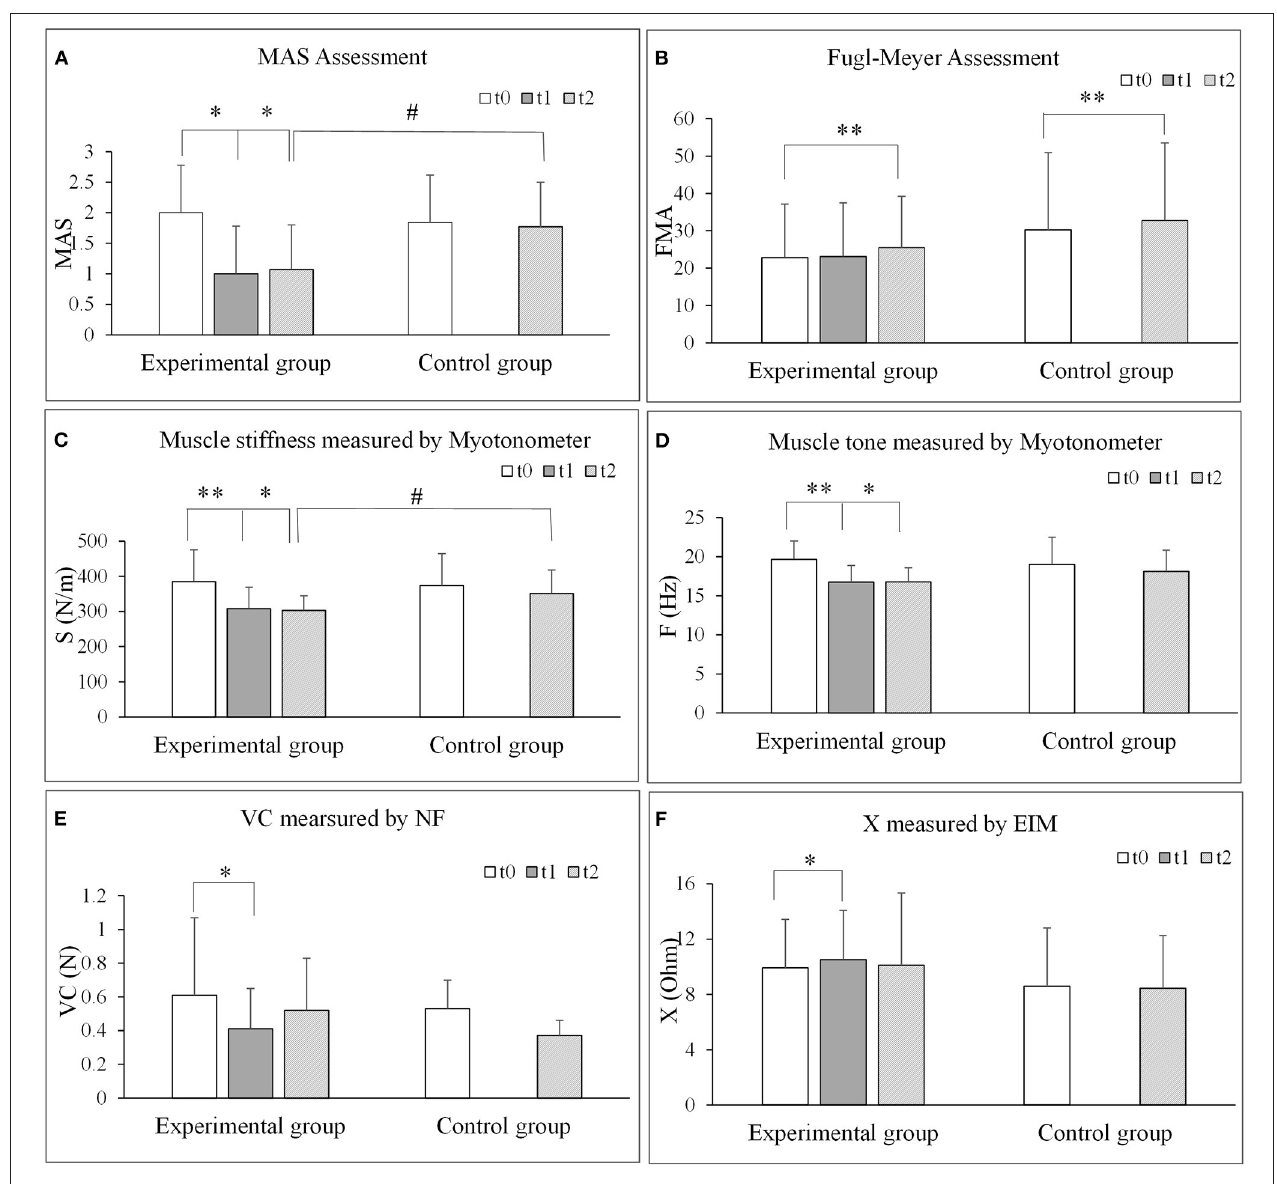
FIGURE 6 | Comparisons of each outcome measures before and after extracorporeal shock wave therapy. (A) MAS assessment. (B) Fugl-Meyer assessment. (C) Muscle stiffness measured by Myotonometer. (D) Muscle tone measured by Myotonometer. (E) VC measured by NF. (F) X measured by EIM. NF, NeuroFlexor; NC, Neural Component; EC, Elasticity Component; VC, Viscosity Component; S, Stiffness; F, Frequency; EIM, Electrical impedance myography; X, Reactance; R, Resistance. * P < 0.05; ** P <